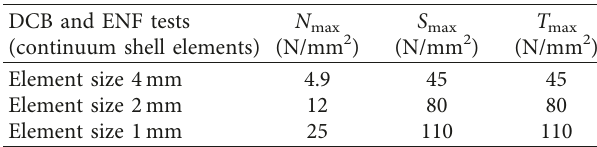
Table 6: Material interfacial strength.